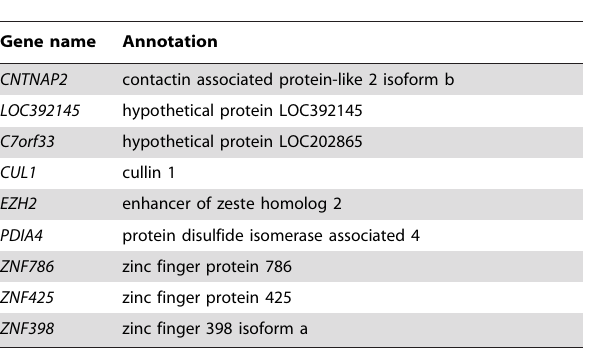
Table 4. Genes located in the 1.33 Mb SRO on 7q35 2